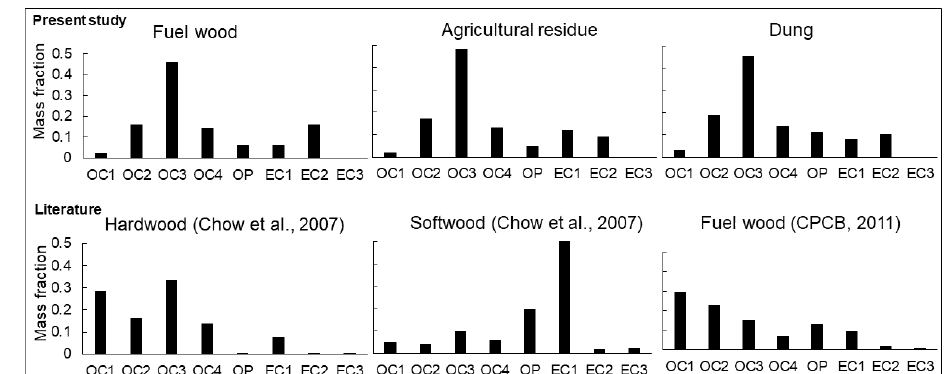
Figure 5. Fraction of total carbon emissions contributed by the IMPROVE_A thermal carbon